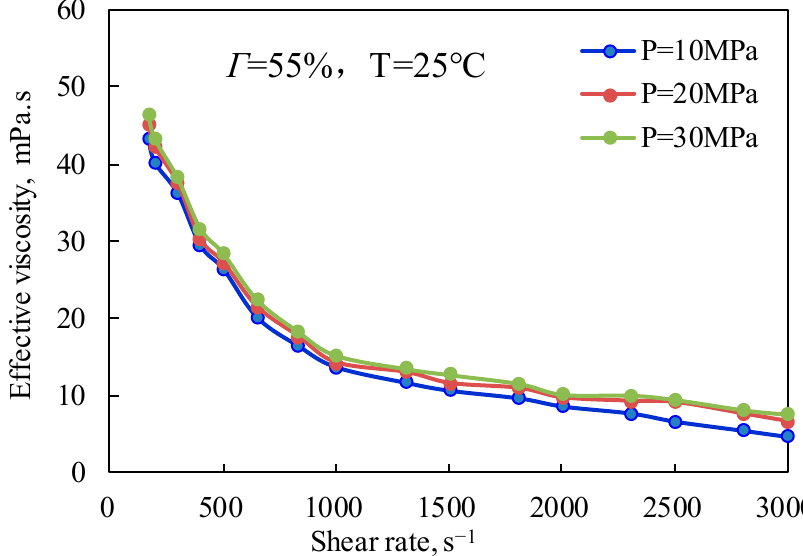
Figure 9. Variation of effective viscosity with shear rate under different pressures (unfoamed).